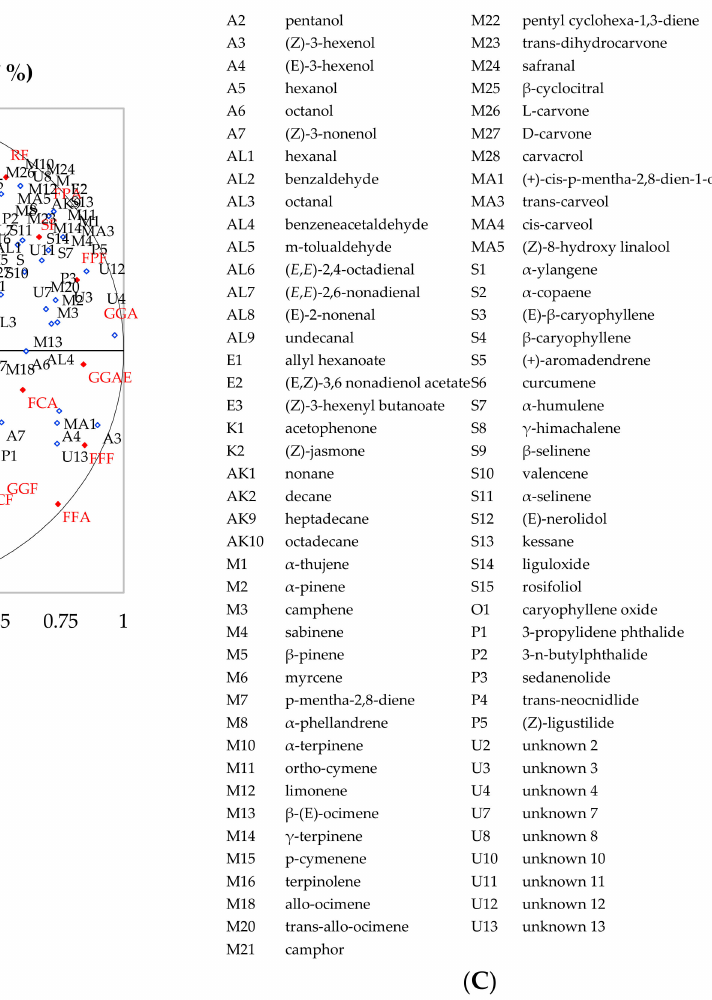
Figure 2. Principal component analysis of six celery samples showing correlations with volatile compounds and sensory profiling: ( A ) projection of the samples; ( B ) distribution of variables, sensory attributes are highlighted in red; ( C ) compound codes as appear in plot ( B